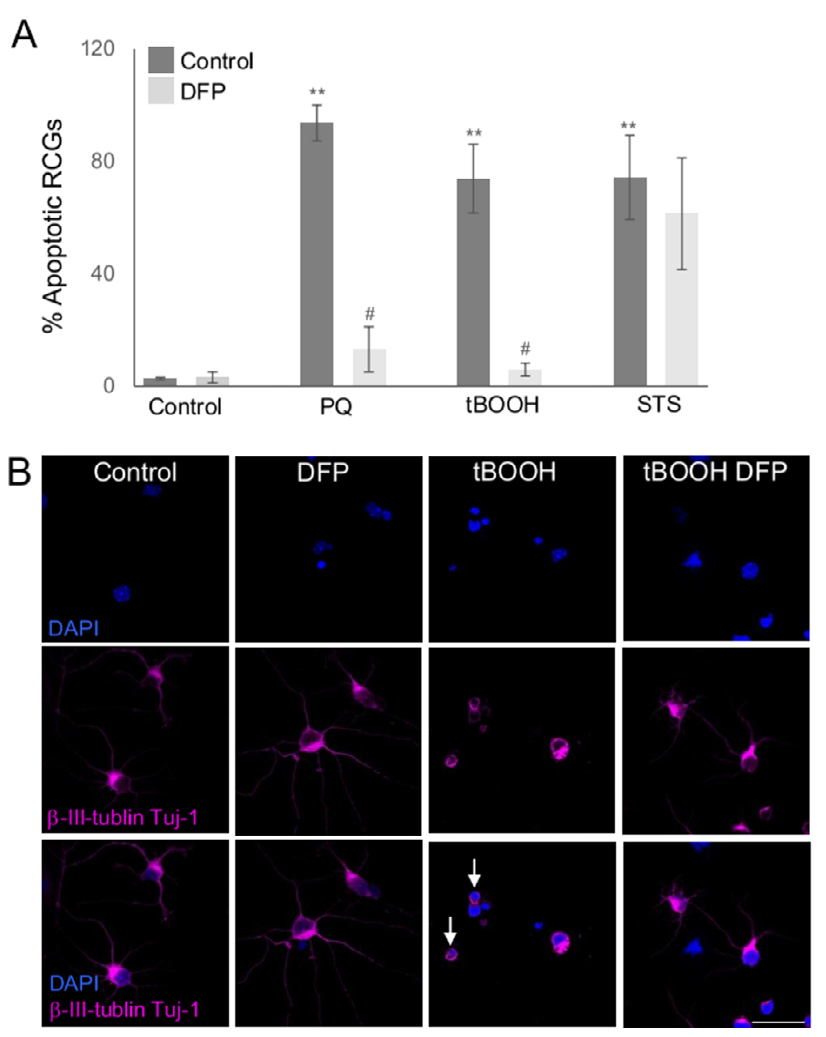
Figure 2. DFP rescues RGC death from oxidative stress inducers. ( A ) Primary RGCs were incubated with 2 mM PQ, 200 µ M tBOOH and 3.5 µ M STS, in the presence or absence of 0.25 mM DFP for 24 h. After the incubation cells were fixed and stained with β -III-tubulin (TUJ1) and DAPI. The % of apoptotic RGCs was determined by counting TUJ1 positive cells with condensed apoptotic nuclei. The number of RGCs was counted in at least 5 fields of three di ff erent experiments. ** p < 0.01 vs. control; # p < 0.05 vs. treatment. ( B ) Representative images of cells treated as in A stained with β -III-tubulin (TUJ1, magenta) and nuclei (DAPI in blue). Examples of apoptotic nuclei are depicted with white arrows. Scale bar 50 µm.